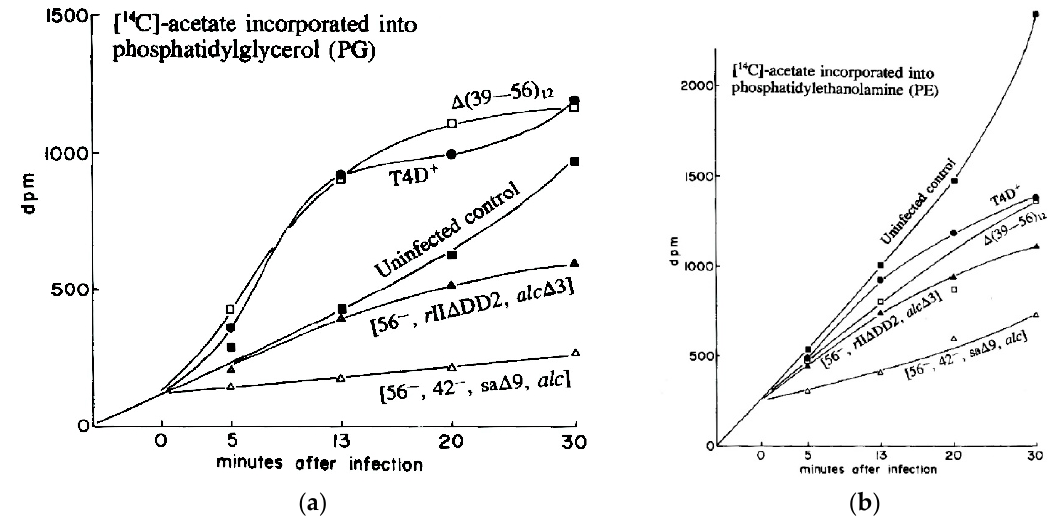
Figure 9. Kinetics of incorporation of [14C] acetate into ( a ) phosphatidyl glycerol and ( b ) phosphatidylethanolamine. Uninfected E. coli CR63 is compared with E. coli CR63 infected with T4D or with various multiple mutants of T4: [ ∆ ( 39–56 )12]; [sa ∆ 9, alc ∆ 3, am gene 42 (HMase), am gene 56 (dCTPase)], or [ rII ∆ DD2, alc ∆ 3, am dCTPase)]; rII ∆ DD2 partly overlaps sa ∆ 9, as seen in Figure 1. Reproduced from [31].